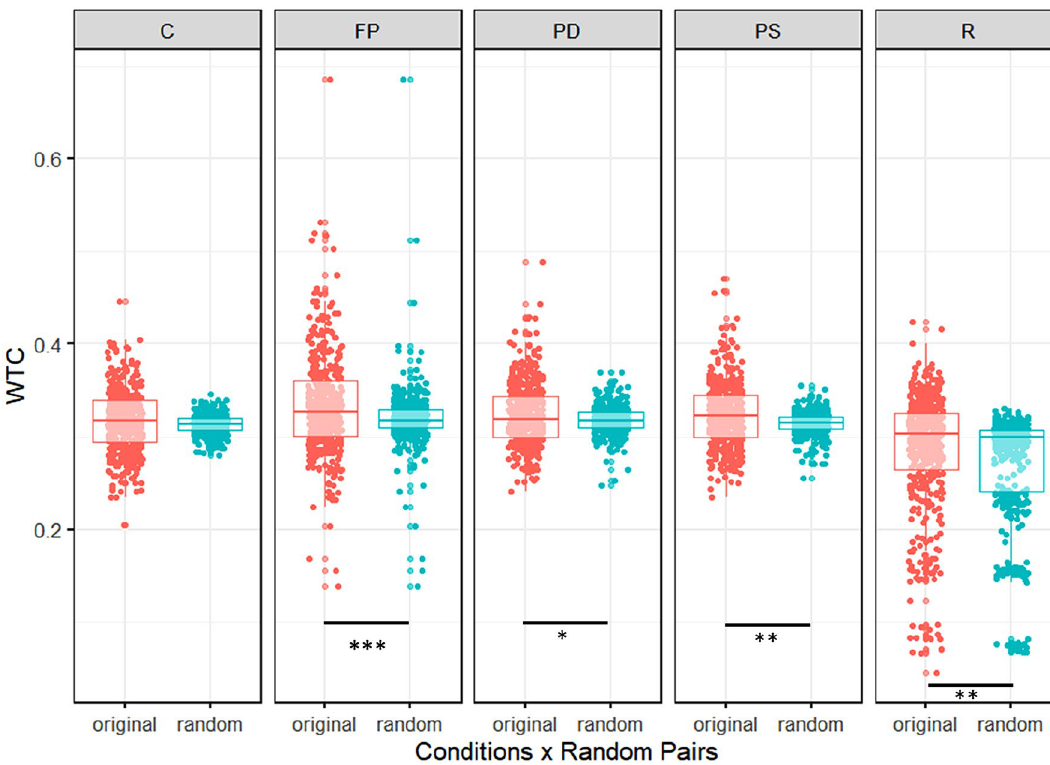
Figure 5. Box plots illustrating WTC values for each experimental condition for original and random pairs for HbR. Free Play (FP), Prediction-Different Action (PD) and Prediction-Same Action (PS) conditions and an average of all resting state phases (R) showed higher coherence in original pairs than in random pairs. The Control (C) condition revealed no significant differences between original and random pairs. * p ≤ 0.05, ** p ≤ 0.01, *** p ≤ 0.001.